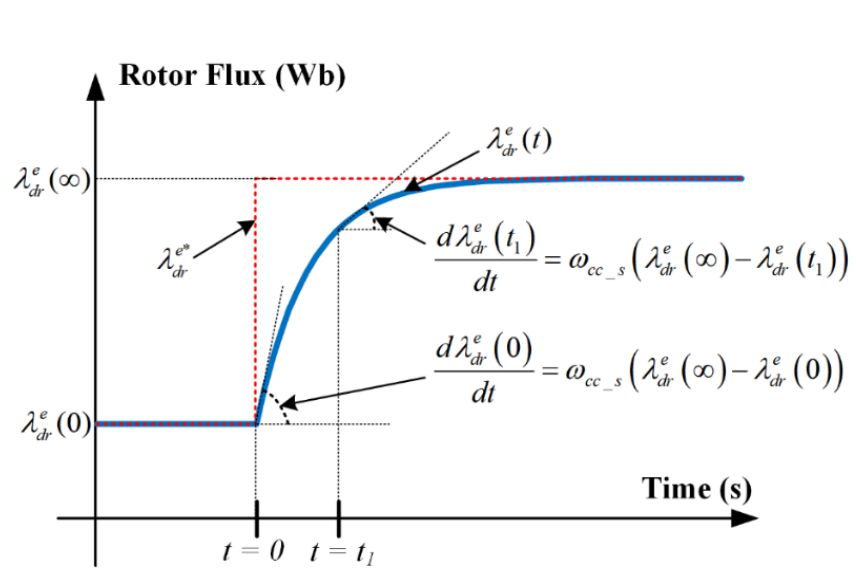
Figure 5. Variation of rotor flux according to stepwise command in the proposed control method of a DIFWM.